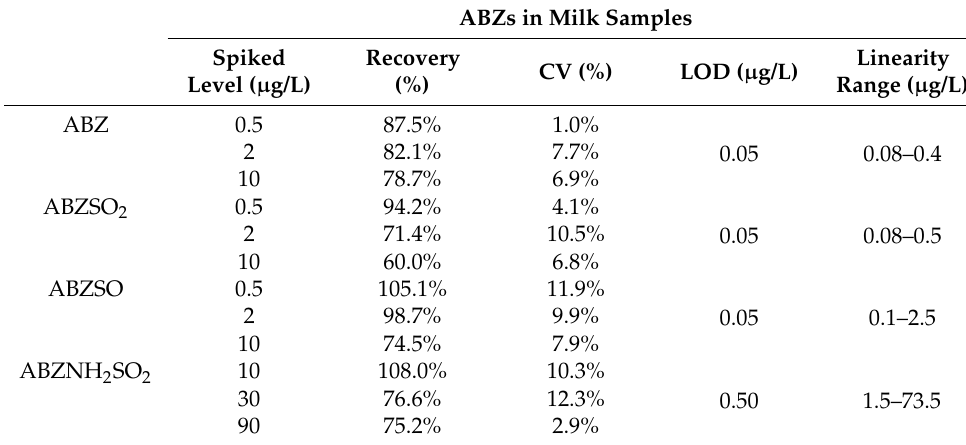
Table 4. Recoveries, CVs, LODs, and linearity range of ABZs in spiked milk samples using ic-ELISA. ( n = 3).